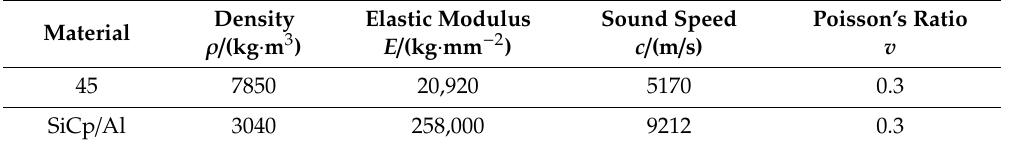
Figure 1. Schematic diagram of the horn. Table 1. Material-related parameters.